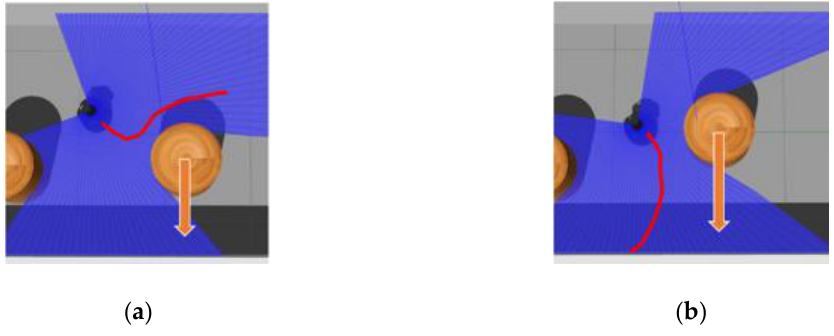
Figure 15. Strategy of ER + MNR when the robot encounters dynamic obstacles: ( a ) success and ( b ) failure